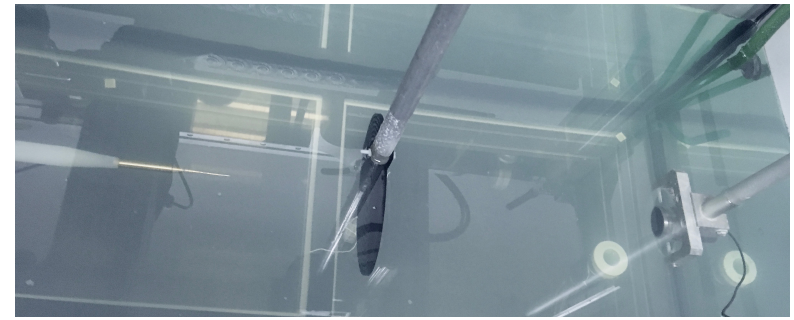
Figure 3. Experimental